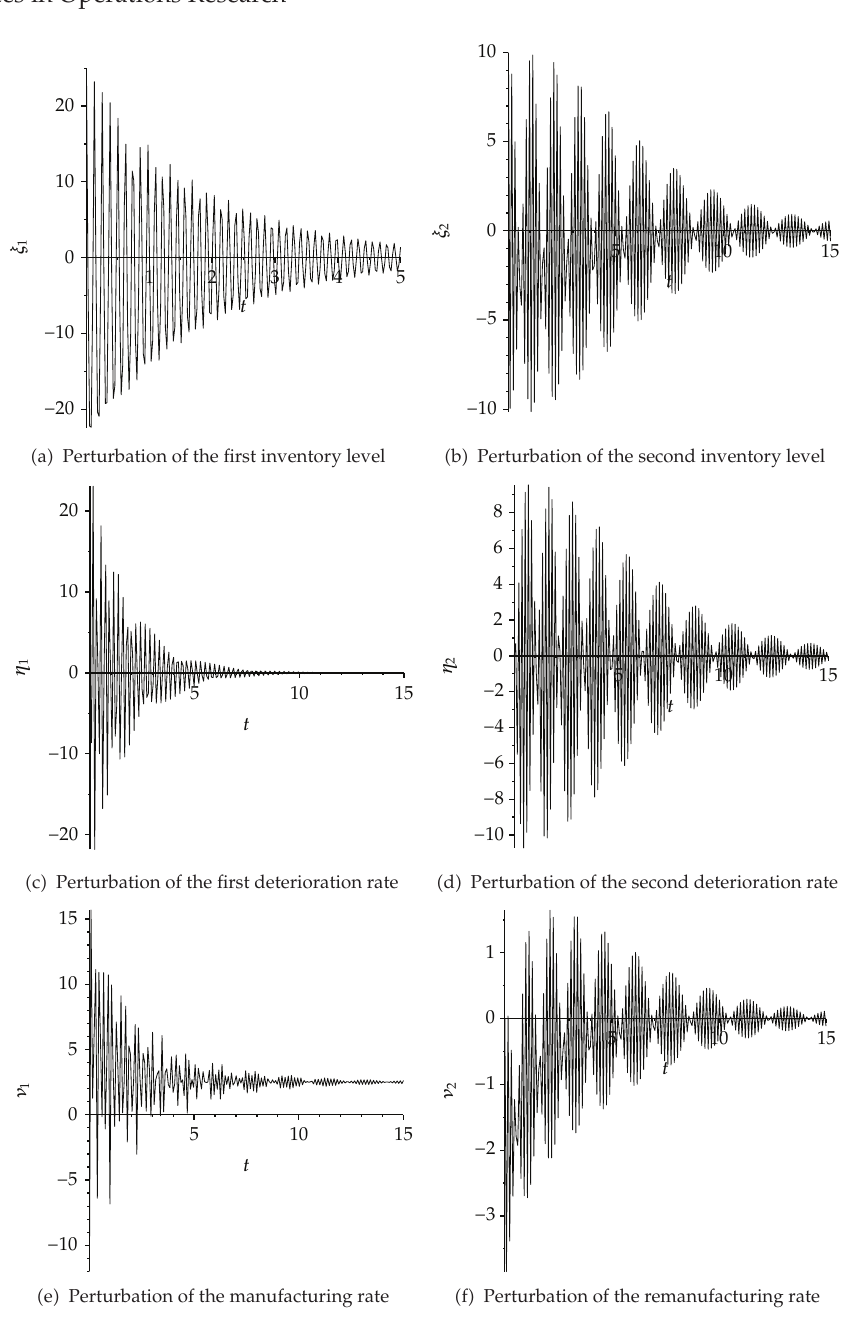
Figure 2: (cid:5) a (cid:6) : the perturbation of the first inventory level ξ 1 (cid:5) t (cid:6) , (cid:5) b (cid:6) : the perturbation of the second inventory level ξ 2 (cid:5) t (cid:6) , (cid:5) c (cid:6) : the perturbation of the first deterioration rate η 1 (cid:5) t (cid:6) , (cid:5) d (cid:6) : the perturbation of the second deterioration rate η 2 (cid:5) t (cid:6) , (cid:5) e (cid:6) : the perturbation of the manufacturing rate ν 1 (cid:5) t (cid:6) , and (cid:5) f (cid:6) : the perturbation of the remanufacturing rate ν 2 (cid:5) t (cid:6) , with the initial perturbations: ξ 1 (cid:5) 0 (cid:6) (cid:7) 25, ξ 2 (cid:5) 0 (cid:6) (cid:7) 10; η 1 (cid:5) 0 (cid:6) (cid:7) 0 . 02, η 2 (cid:5) 0 (cid:6) (cid:7) 0 . 02; ν (cid:5) 0 (cid:6) (cid:7) 25,